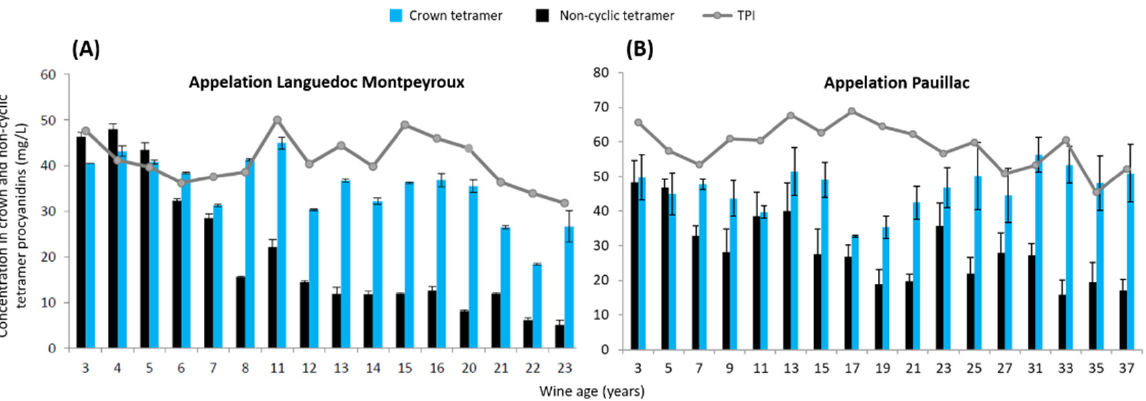
Figure 4. Concentration in the crown and non-cyclic procyanidins’ tetramer, as well as TPI during the aging of red wine in bottles. ( A ) Red wine for Languedoc Montpeyroux appellation and ( B ) red wine from Pauillac appellation.